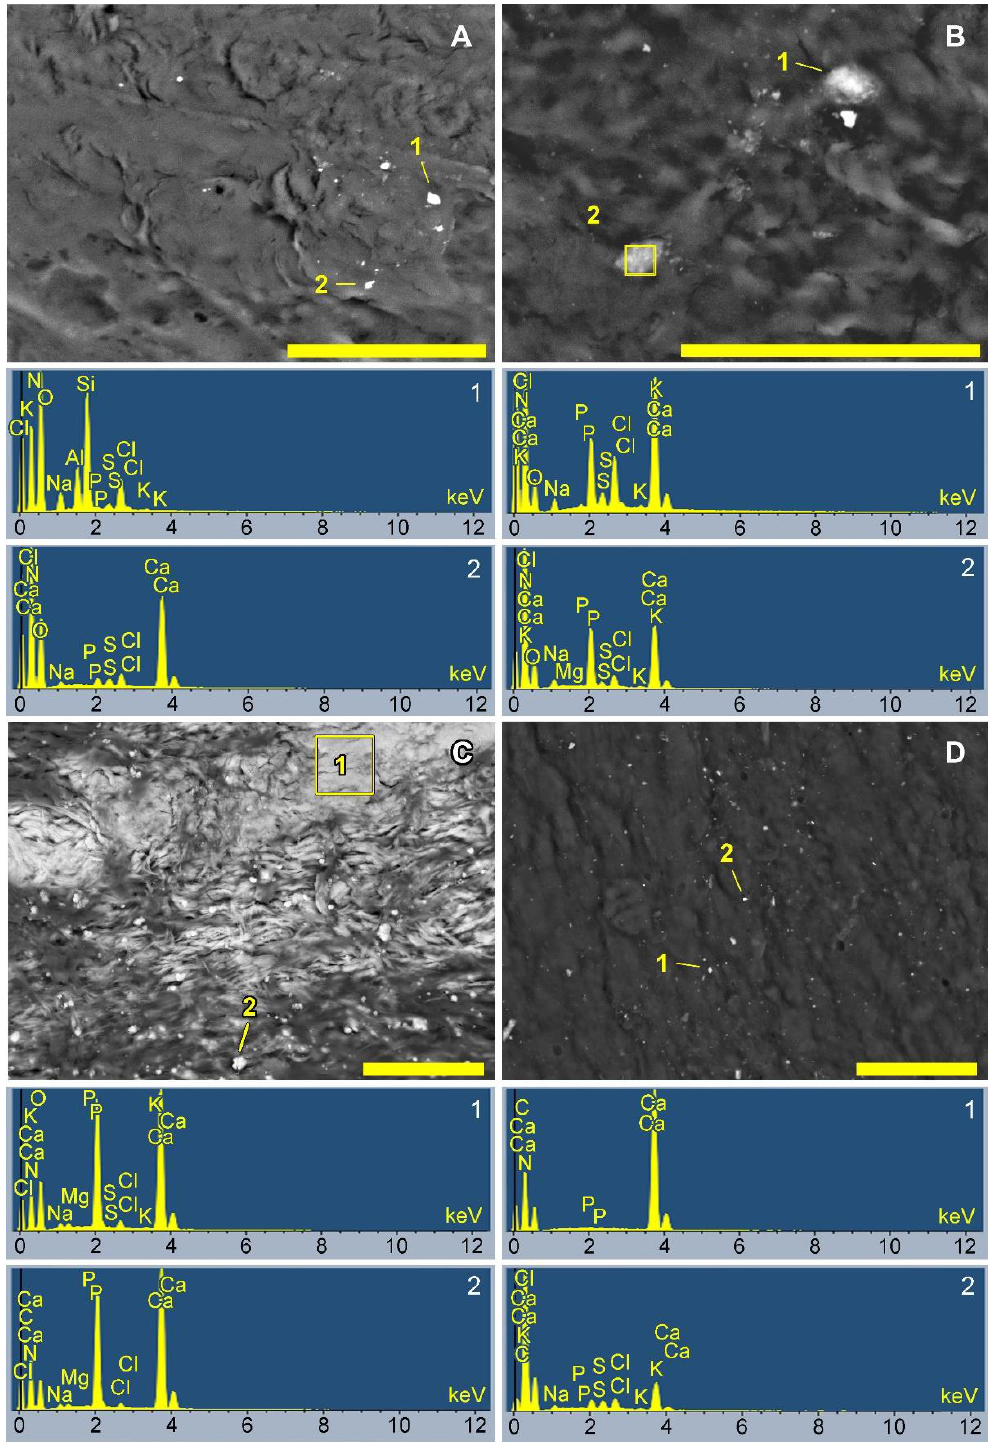
Figure 10. Surface SEM images of GA-Ve 10 days after implantation ( A ), DE-Ve 30 days after im- plantation ( B ), GA-Ao 30 days after implantation ( C ), and (GA + PAM)-Pe 30 days after implantation ( D ). Each image is accompanied by two characteristic elemental spectrа of spots or areas indicated on the corresponding image. Scale bars: 50